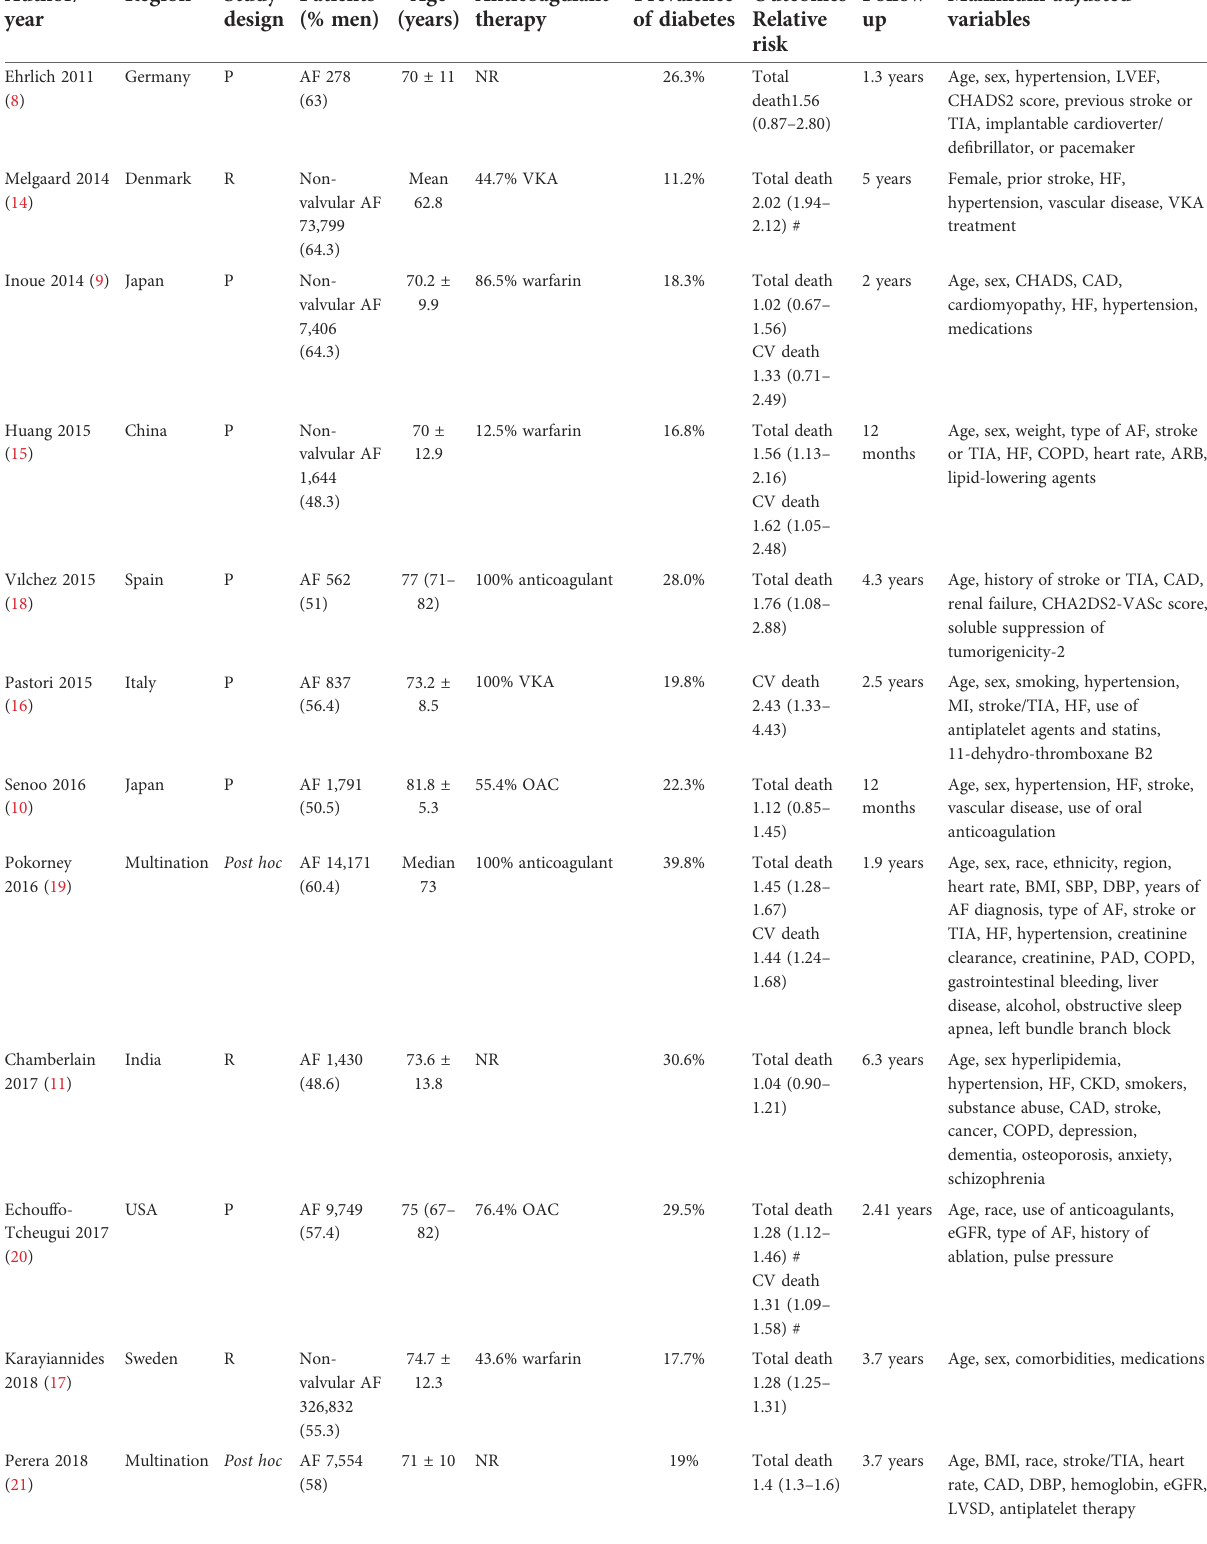
TABLE 1 Baseline characteristic of the included